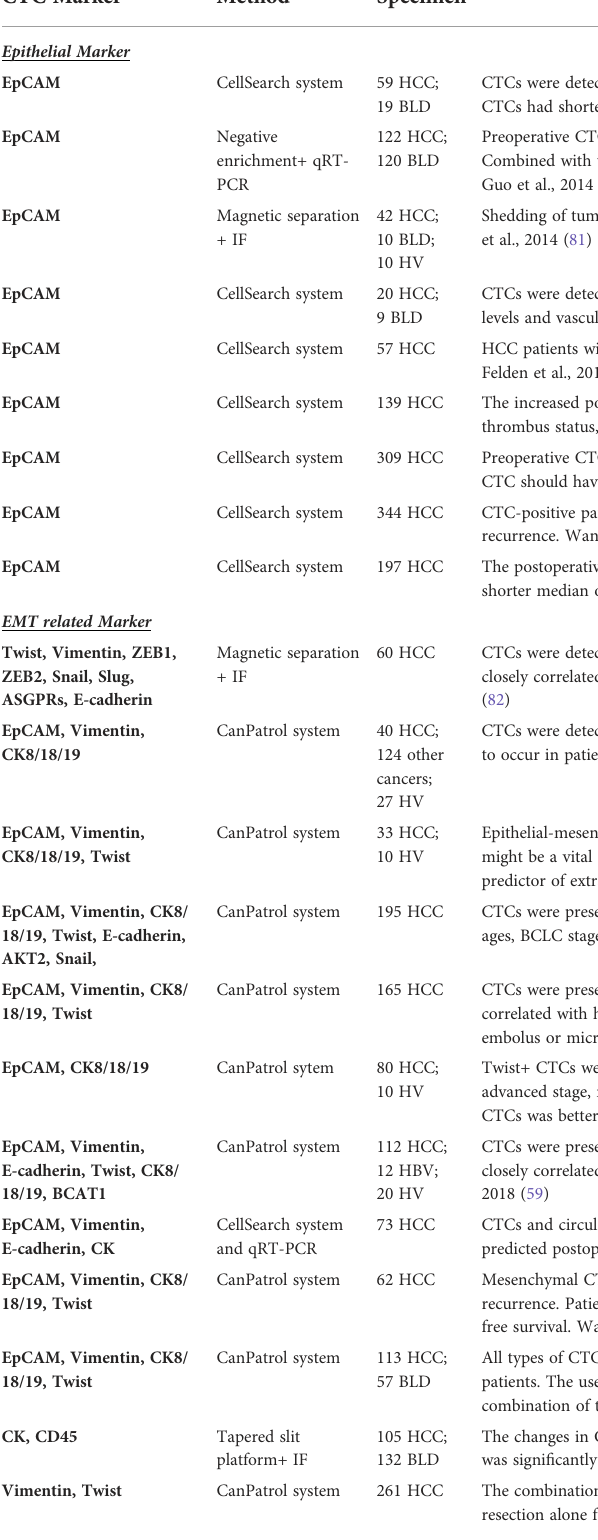
TABLE 1 Summary of clinical application of CTCs in